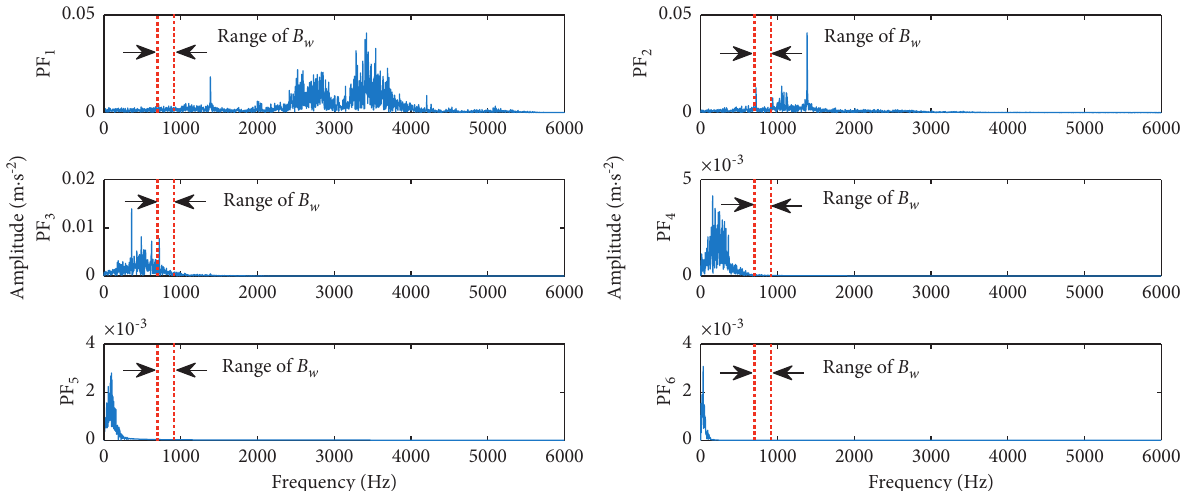
Figure 5: Calculated PF components with the ELMD algorithm for the benchmark dataset.